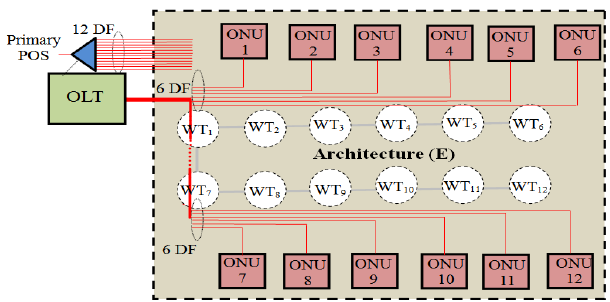
Figure 7. EPON ‐ based architecture (E).